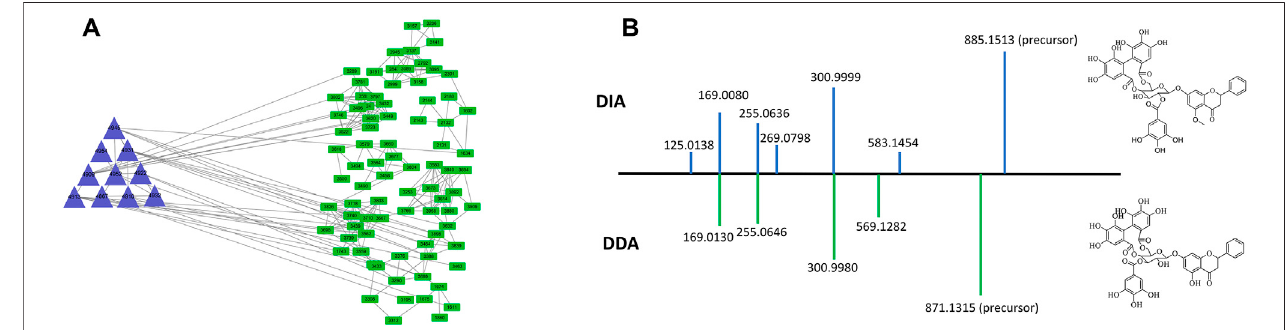
FIGURE 3 | Representative example showing the effectof DDA-assisted DIA on the sensitiveprecursor ion. The MS features retrieved from DDA-assisted DIA (A) , with similar MS 2 features of polyphenols in P. chinense (B) .